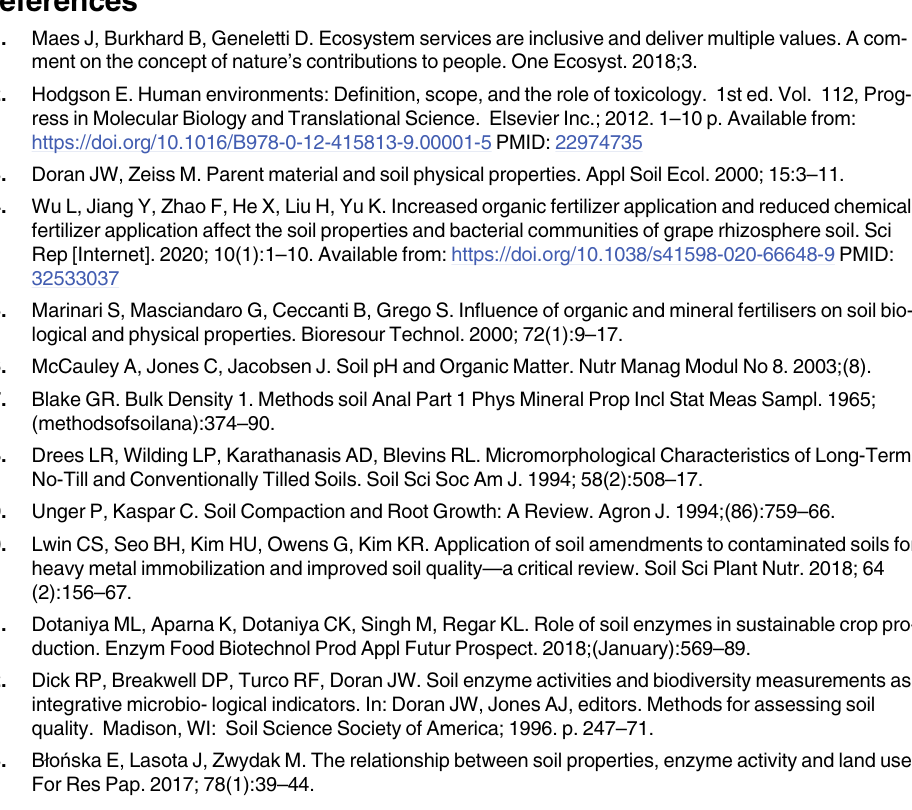
S1 Table. List of bacterial taxa detected in all soil samples, summarized in OUT tables (a table for each taxonomic level is provided in a separate